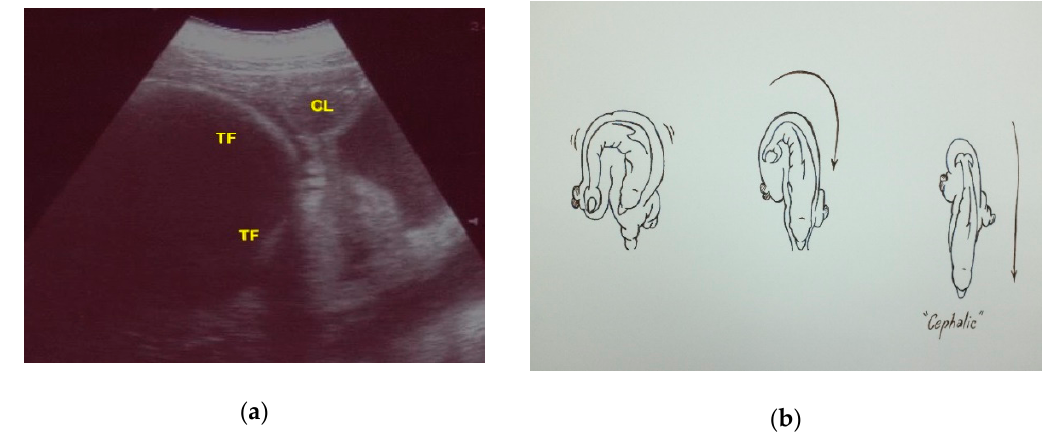
Figure 13. ( a ) Using the CL as a reference, if the tail fluke (TF) is located close to the CL, it will have a cephalic position at birth, ( b ) as shown in the image.